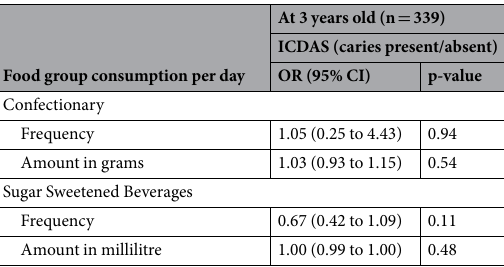
At 3 years old (n = 339)